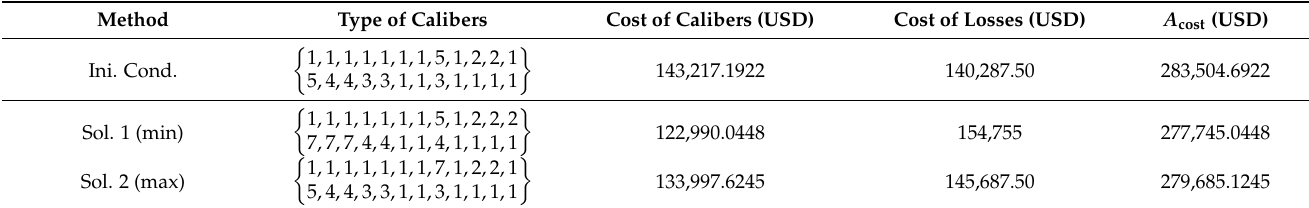
Table 12. Numerical results for the alternative 25-bus